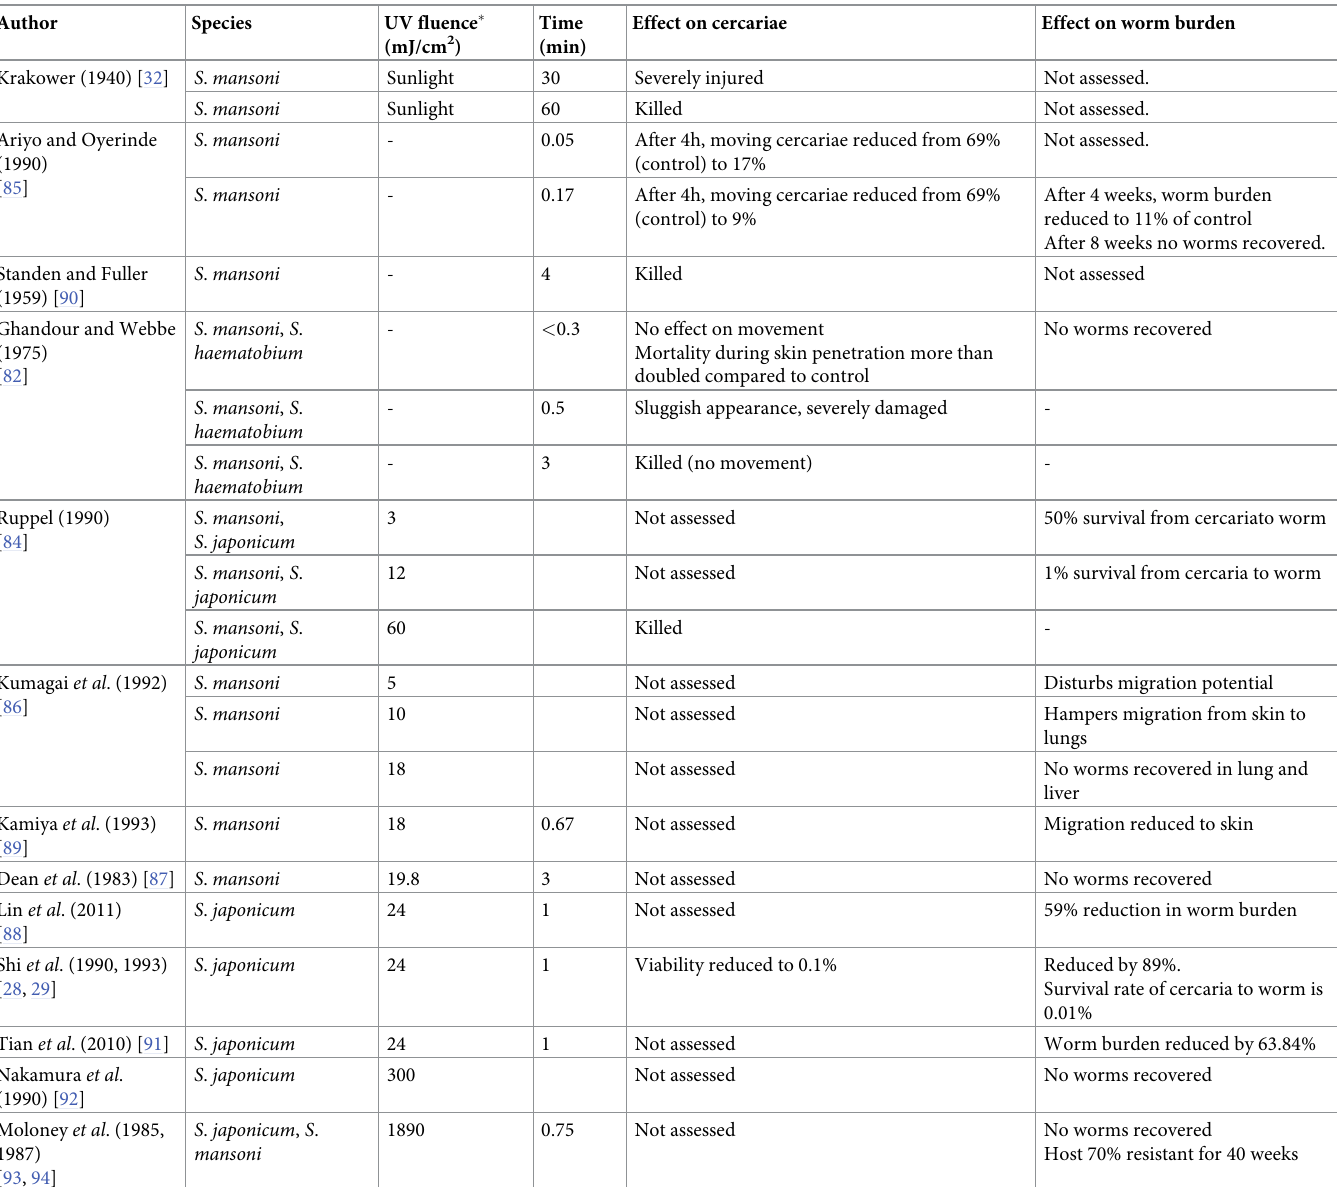
Table 7. Effect of UV disinfection on cercariae and worms. (cid:3) All fluences at 254nm.